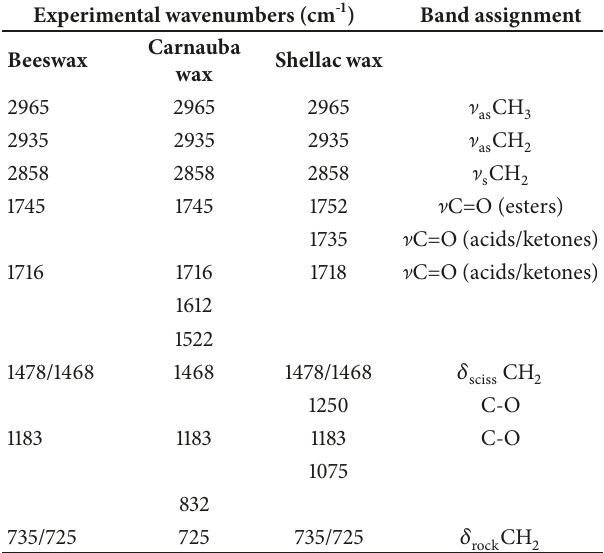
Table 2: Experimental wavenumber values corresponding to the maxima of the mid-IR total reflection mode bands of lipid materials and their tentative